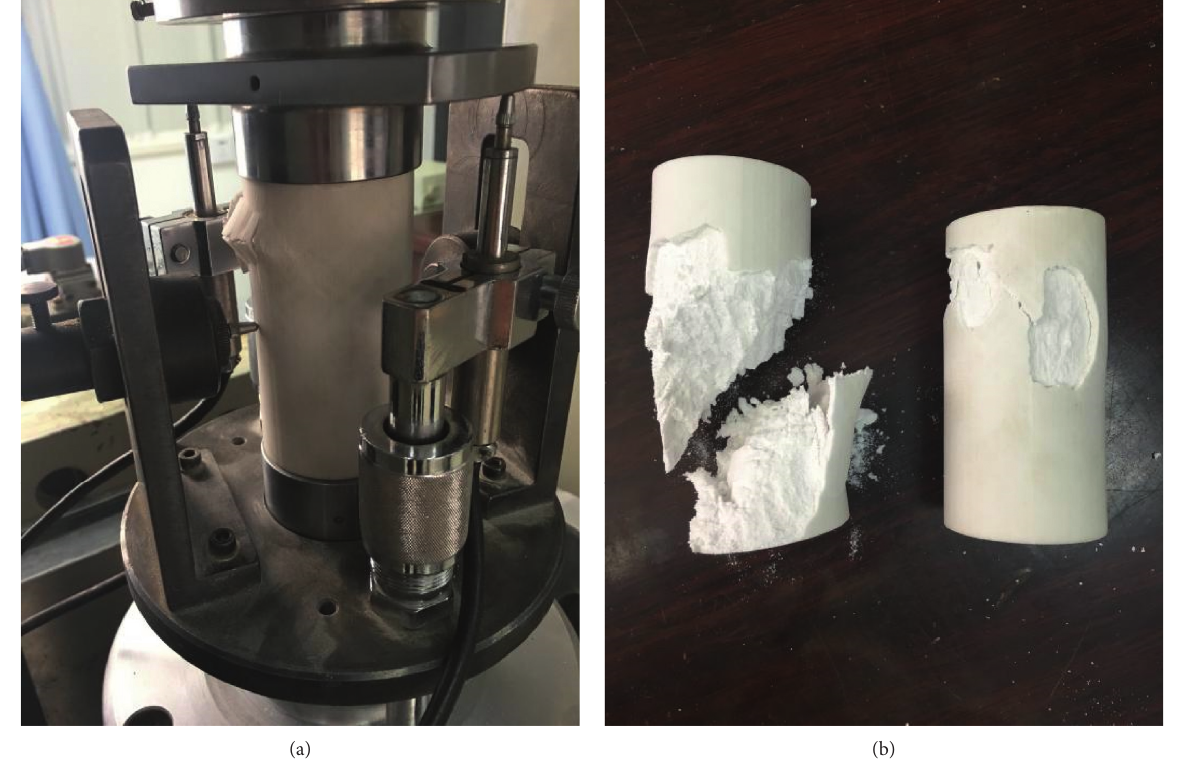
Figure 4: Failure pattern of specimens with default printing mode in UCS test. (a) Crack initiation. (b) Complete